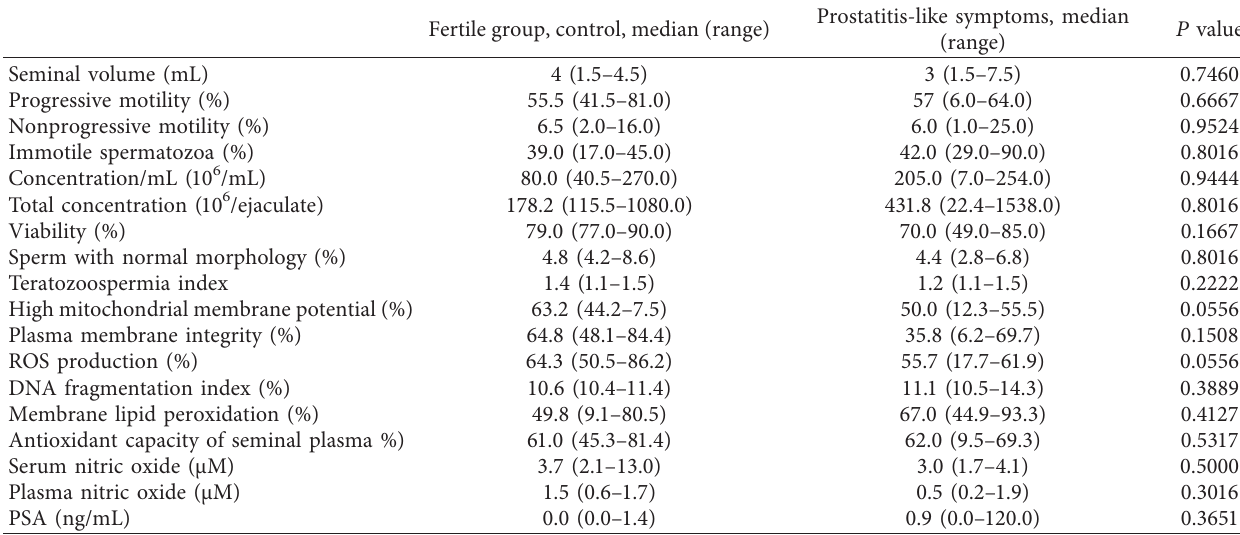
Table 2: Seminal quality and oxidative stress in prostatitis-like symptoms men and fertile men. Fertile group, control, median